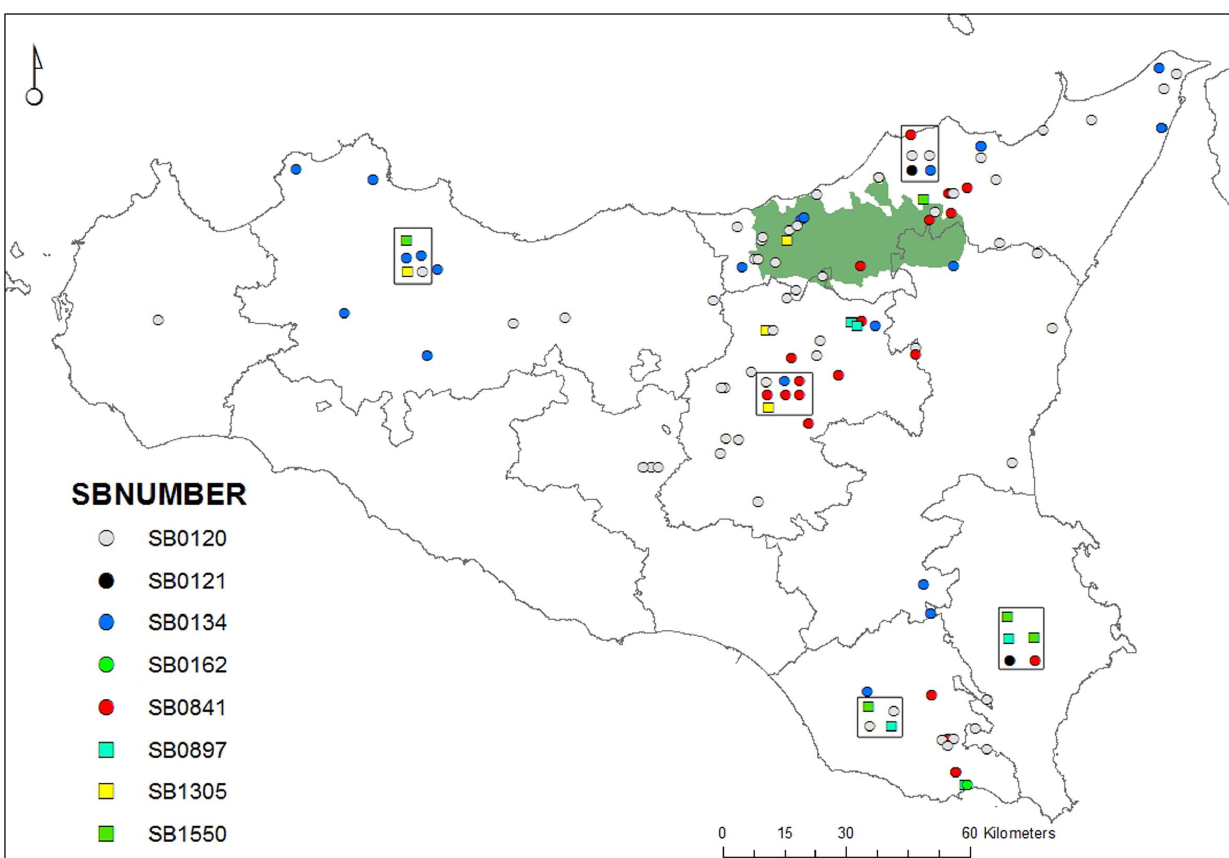
Figure 2. Mycobacteriumbovis isolates from cattle by spoligotype pattern in Sicily. Map of Sicily. Solid grey lines indicate province boundaries. Dots represent individual Mycobacterium bovis isolates from cattle by spoligotype pattern. Dots in squares represent isolates with unknown geographical origin. Only the frequent patterns are represented. The area of the Nebrodi park, where free-ranging pigs contribute to M. bovis maintenance is shadowed. Cases are more frequent close to Nebrodi and close to Hyblaean Mountains and Ragusa (in the South) where there are high numbers of dairy cattle.